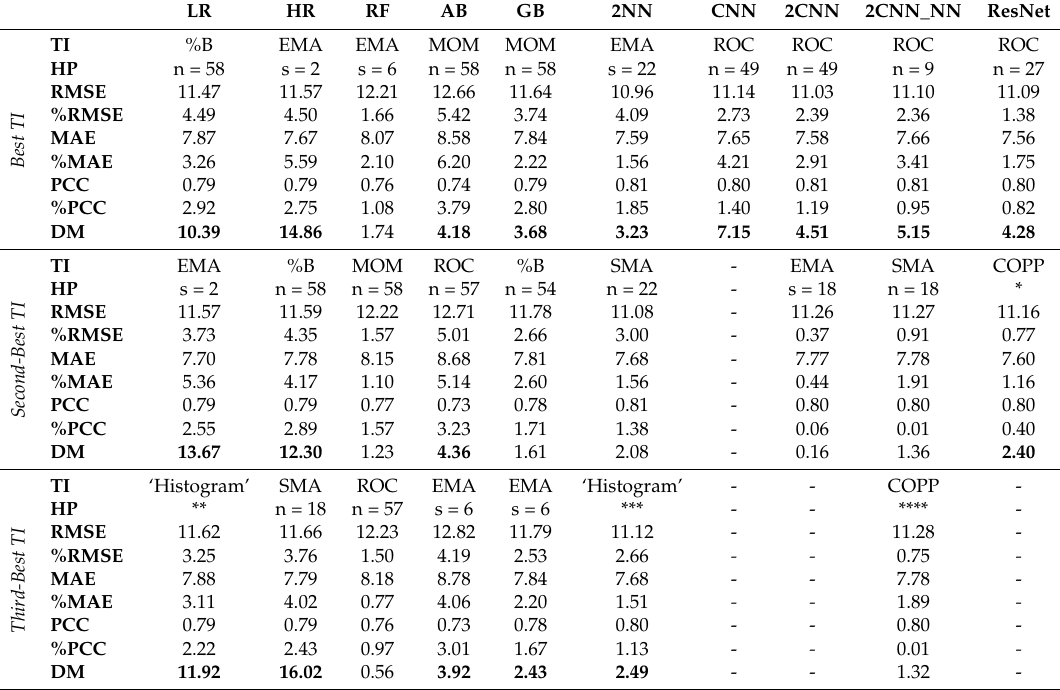
Table 1. Summary results, showing the three best performing—lowest RMSE —TIs for each model. Raw evaluation metrics— RMSE , MAE , and PCC —measure TI model performances. Percentages— %RMSE , %MAE , and %PCC —measure TI model performance improvements. Bold DM values represent statistically significant performance improvements at a 1% significance level.